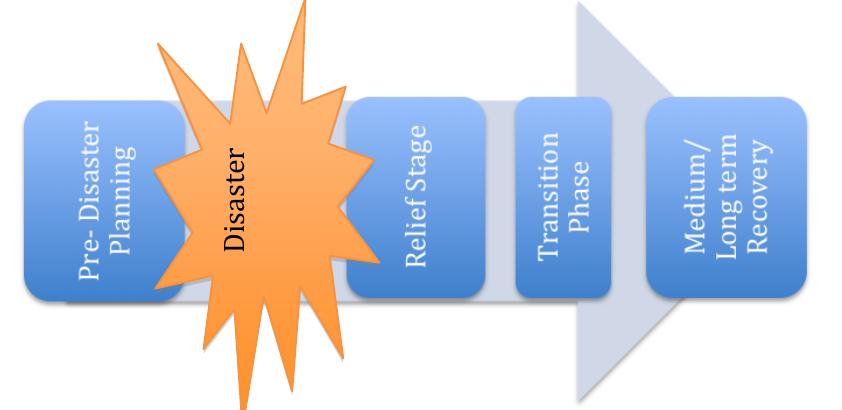
Figure 1 Stages of Disaster Recovery (Lloyd-Jones,